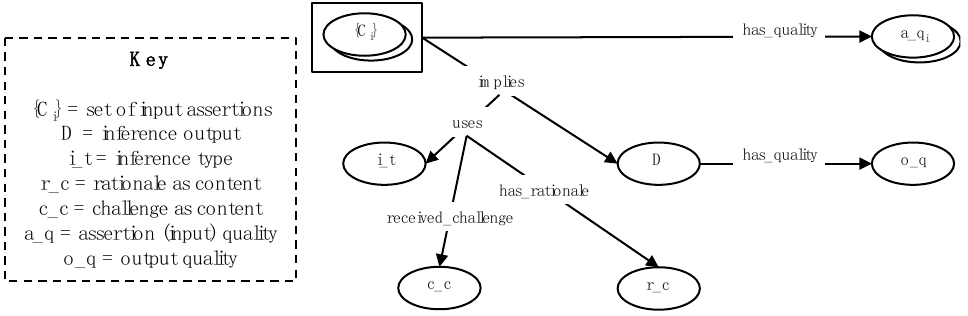
Figure 3. Single inference patterns.